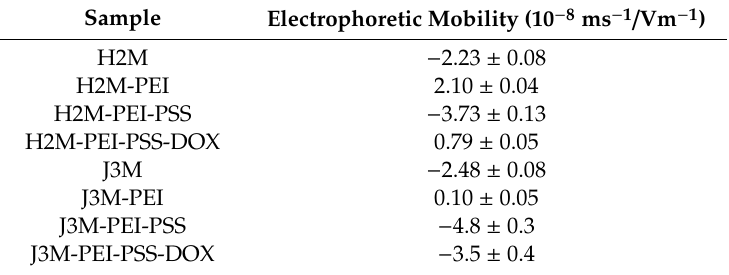
Table 1. Electrophoretic mobility of bare MNRs, and of the same particles after being coated with polyelectrolytes as indicated. The mobility measured after contact with DOX in solution is also included.